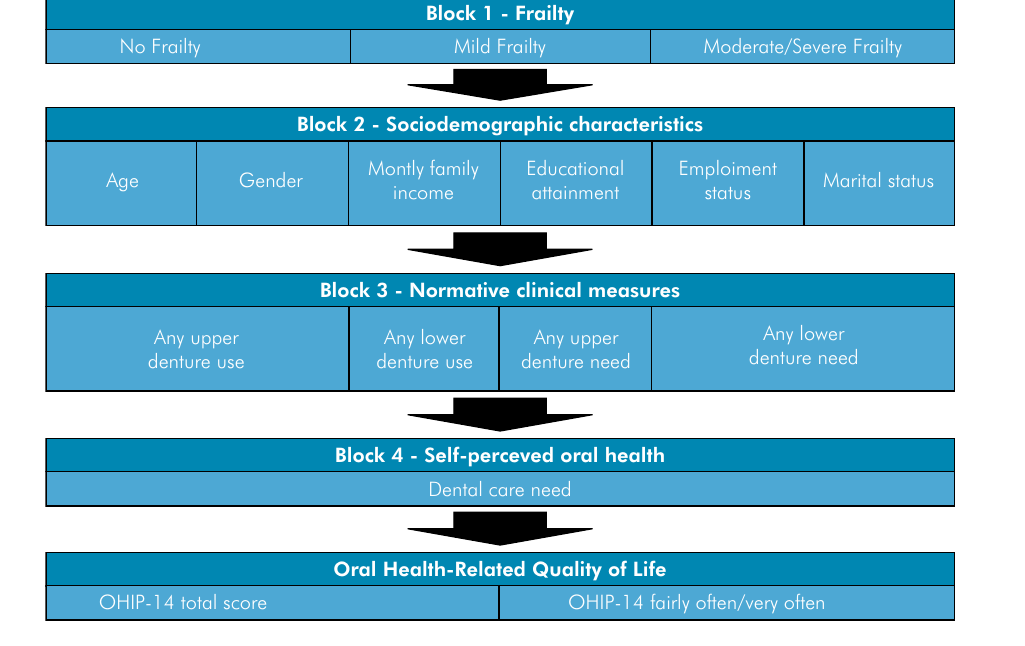
Figure 1. Theoretical conceptual model concerning frailty impact on OHRQoL of the community-dwelling older